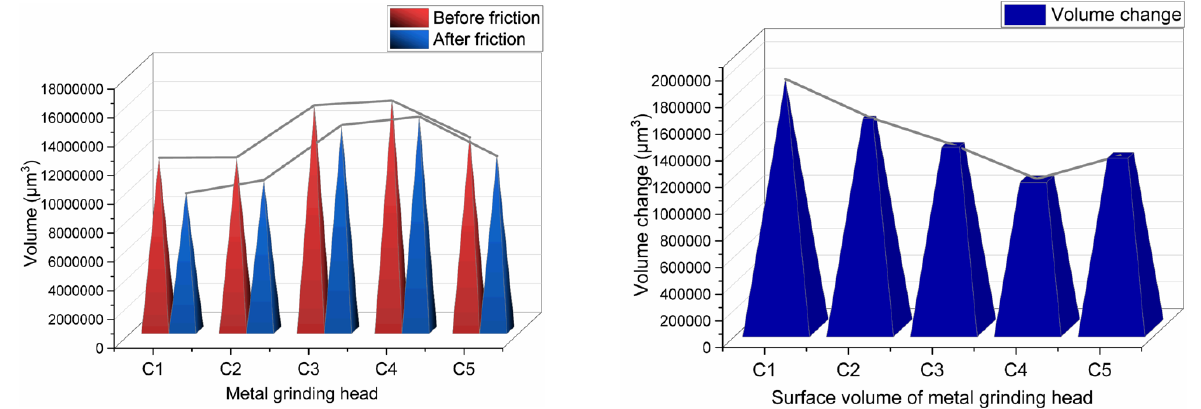
Figure 13. Change in the metal volume before and after friction.